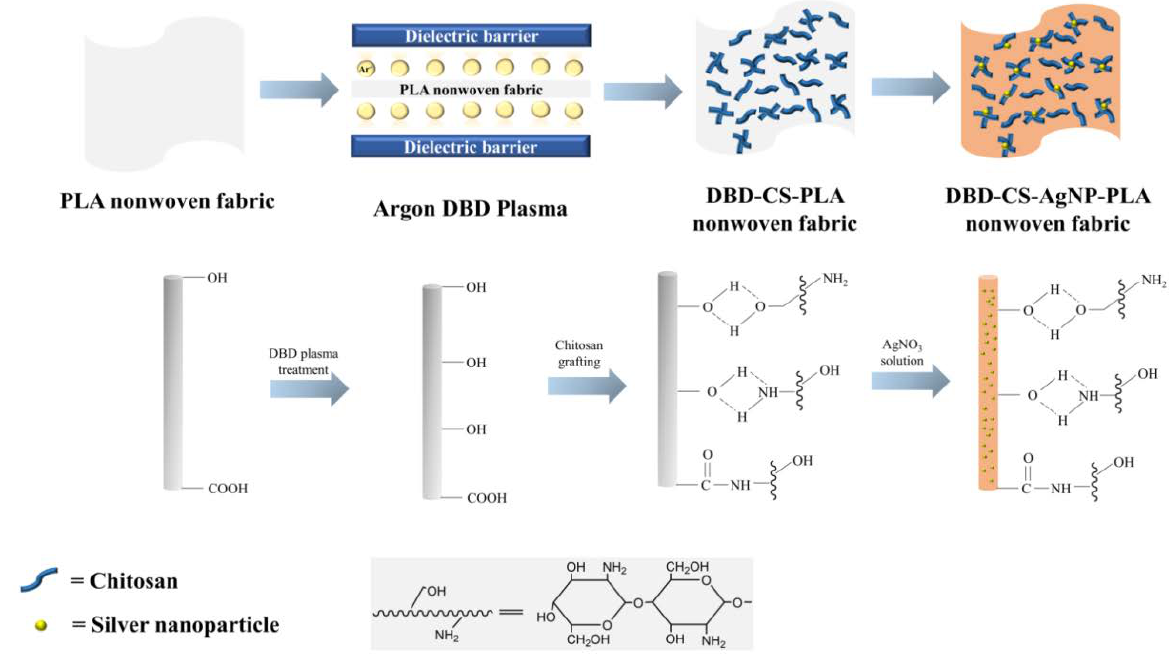
Figure 9. The possible mechanism of chitosan deposition on PLA nonwoven fabrics pretreated by plasma and the original flavor reduction of silver nanoparticles.